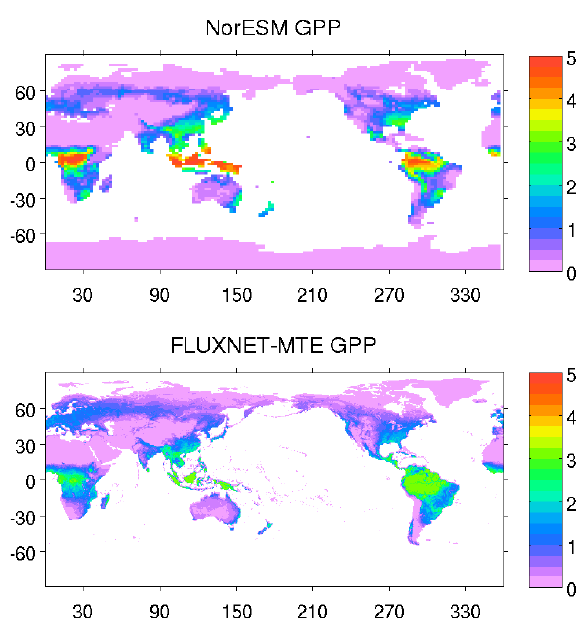
Fig. 18. Maps of mean annual terrestrial gross primary production as simulated by the NorESM model (top) and as estimated from the FLUXNET-MTE observation (bottom). Values are computed from historical 1982–2005 period. Units are in (kgCm − 2 yr − 1